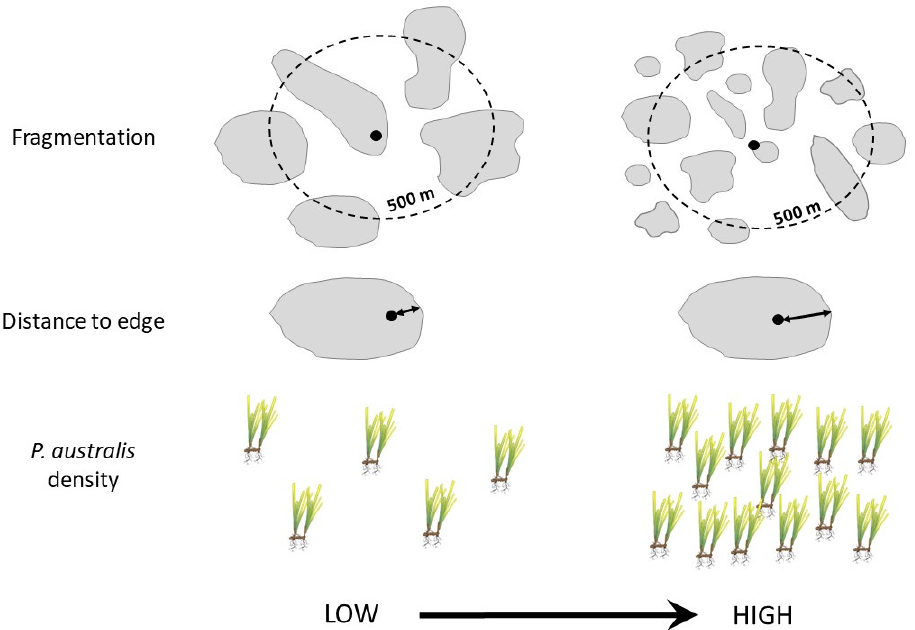
Figure 2. Description of the variables used to measure seagrass complexity and included in the analyses. The dot represents a GPS sampling site. Fragmentation (seagrass perimeter-area ratio in a 500 m radius from each GPS sampling site, dashed lines), distance to patch edge (double arrows) and P. australis shoot